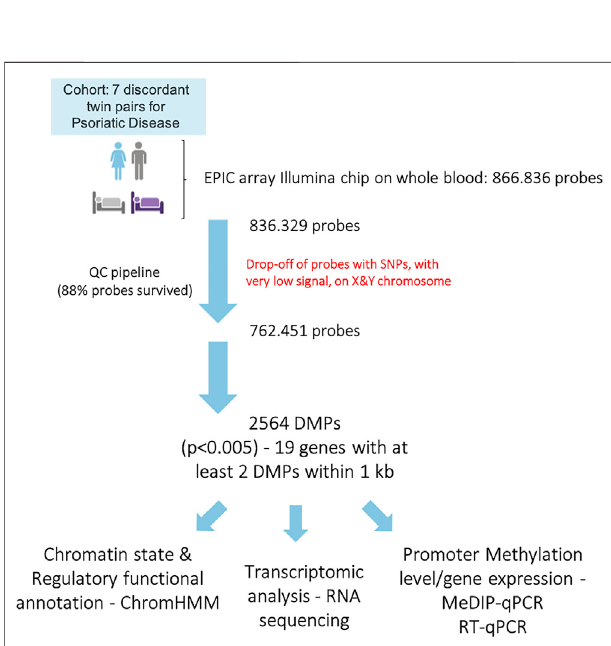
FIGURE 1 | Schematic work fl ow of the study and analysis conducted.